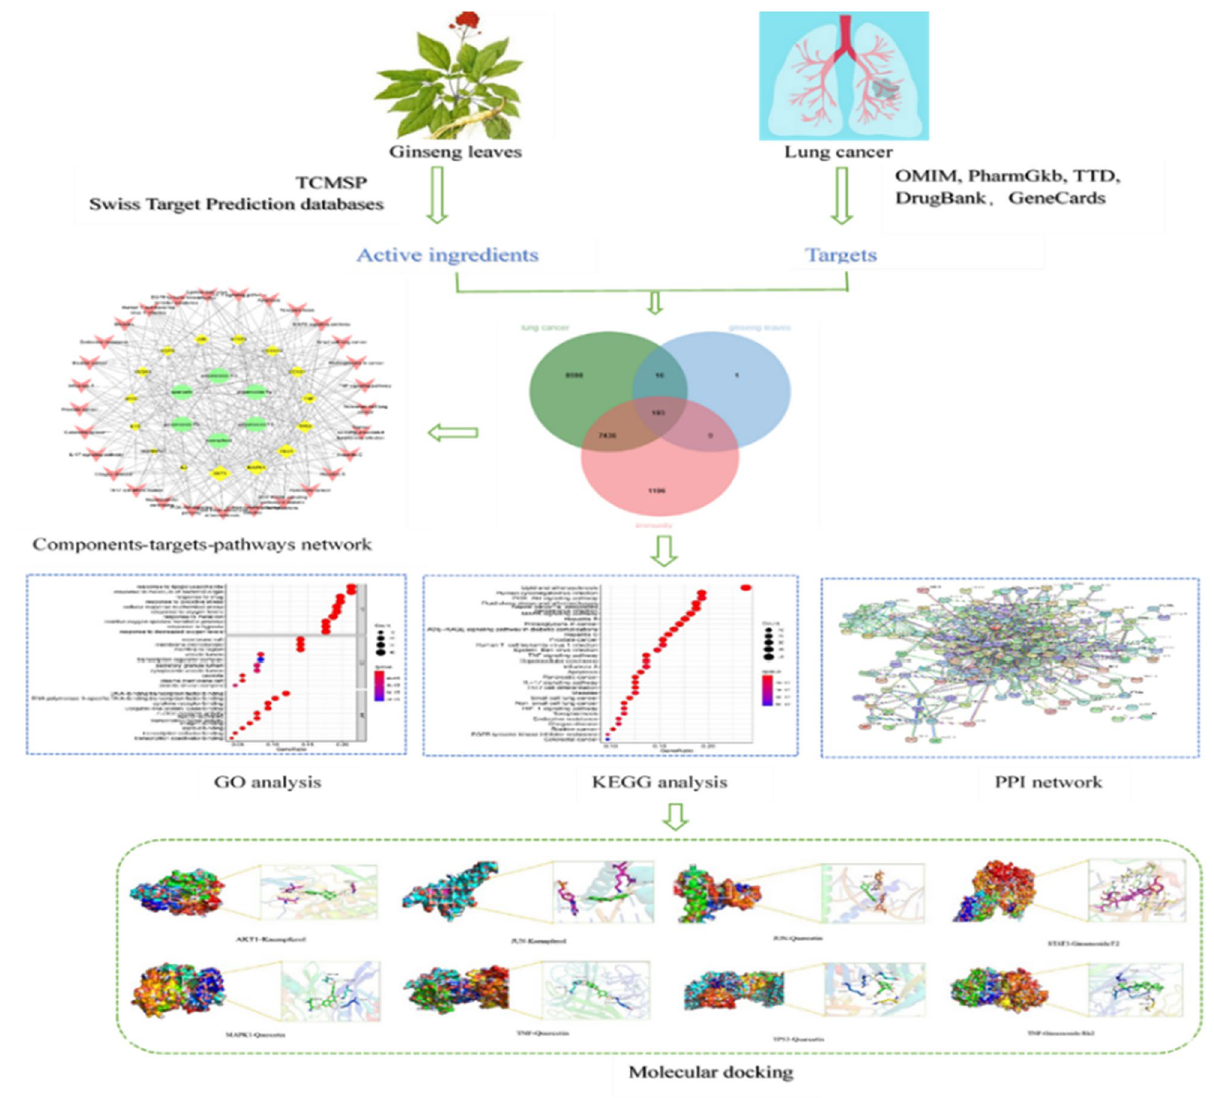
Figure 1. Workflow diagram of the network pharmacology-based analysis of ginseng leaves in the treatment lung